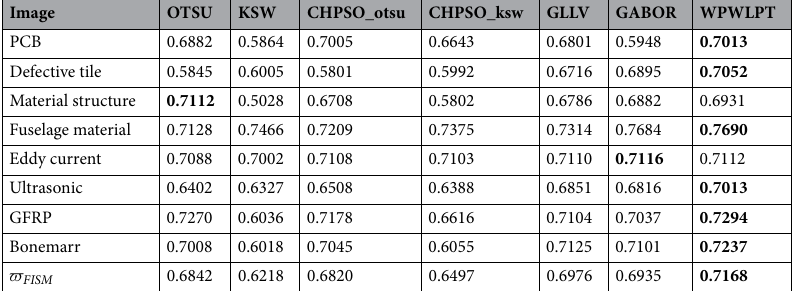
Table 5. FSIMs of the different thresholding methods. The best results are highlighted in bold.